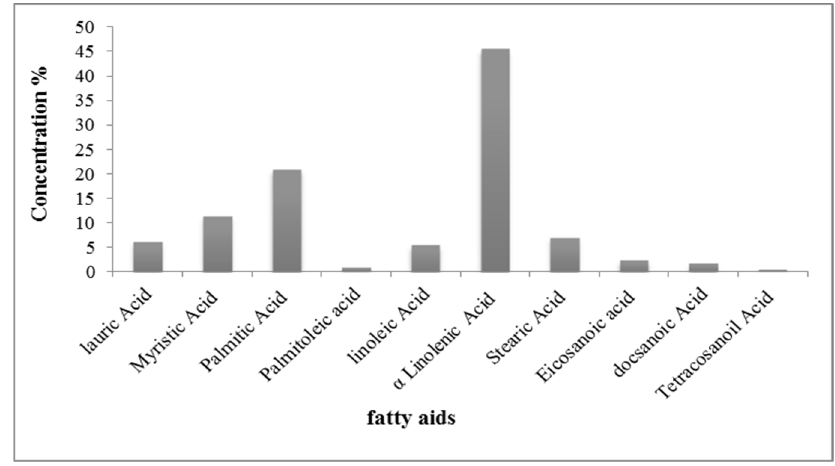
Figure 6. Types of fatty acid extracted from gorse flower.